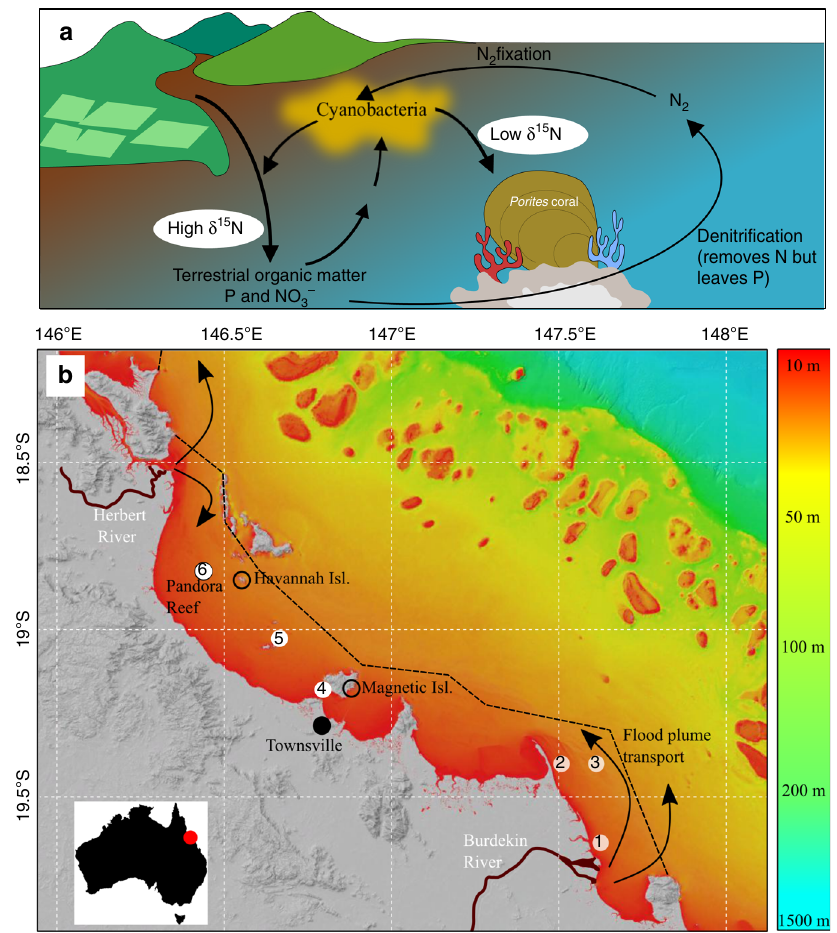
Fig. 1 Great Barrier Reef nitrogen cycle and study sites. a Simpli fi ed conceptual model of nitrogen cycling in the coastal GBR. Terrestrial organic matter, P, and NO 3 − are transported by river runoff. The organic matter and NO 3 − in runoff fuels denitri fi cation but P accumulates in the system. The low N:P ratio stimulates N 2 fi xation which supplies low δ 15 N-N to coastal corals and subsequently decreases their skeletal δ 15 N. The δ 15 N of terrestrial N is higher than that derived from N 2 fi xation. b Bathymetric map of the central GBR 67 showing the location of Havannah Island and Pandora Reef (black circles). The Burdekin and Herbert Rivers, and the generalised direction of fl ood plume transport (black arrows) are shown. The location of a previous study (Magnetic Island) is also shown. The white numbered dots are the locations of fl ood plume and coastal water samples collected in March 2019 (sites 1 – 5), and November 2018 (sites 4 – 6), respectively. The dotted line encloses the area used to convert literature areal values of N 2 fi xation into N loads per